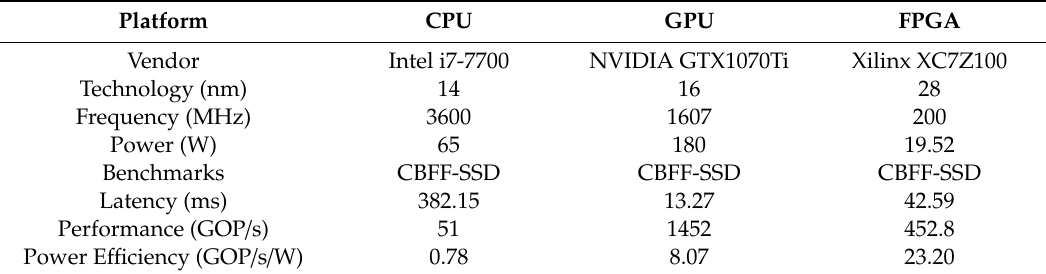
Table 4. Evaluation results on CPU, GPU, and our processor.